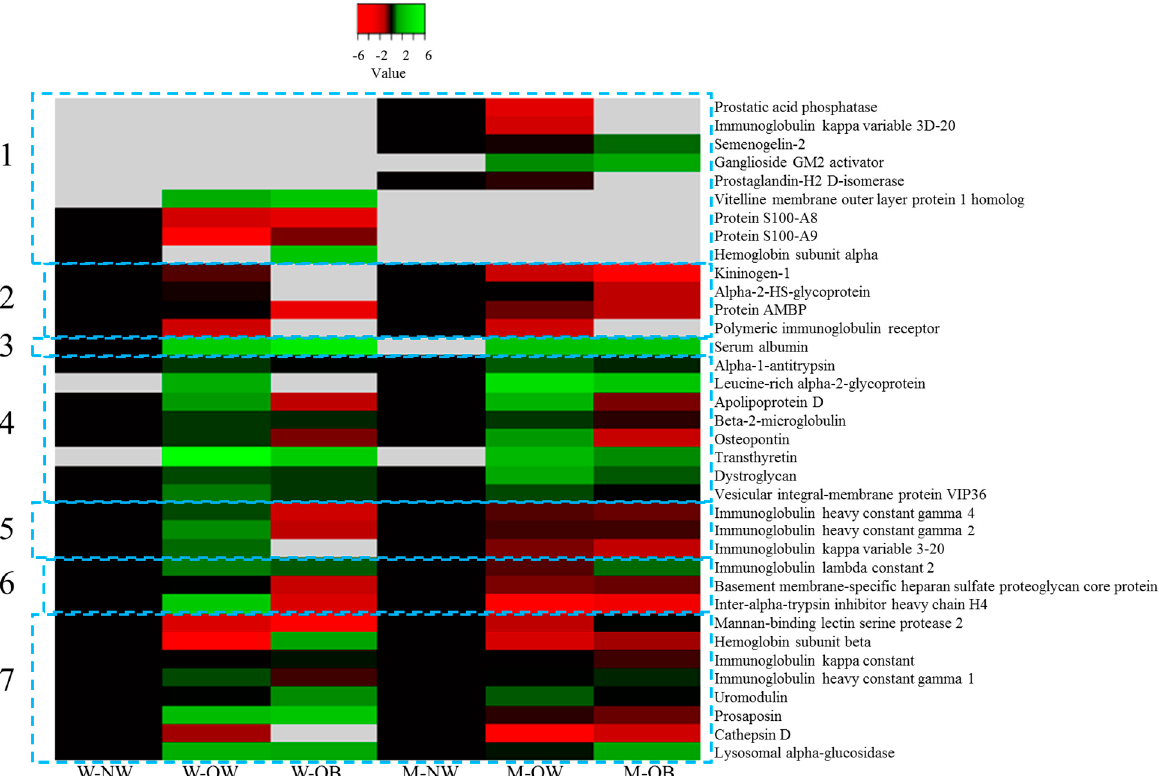
Figure 3. Heat map of the 36 proteins identified by LC-MS/MS. Columns represent groups of women (W-NW) or men (M-NW) with normal weight (controls), overweight (W-OW, M-OW) and obesity (W-OB, M-OB). Rows indicate individual identified proteins. Proteins not detected in any group/condition are indicated in gray. Increased and decreased protein abundance in the different groups compared to respective normal weight conditions are indicated in green or red, respec- tively. Protein names are indicated on the right side. Dashed blue boxes indicate protein clusters with similar abundance change patterns.